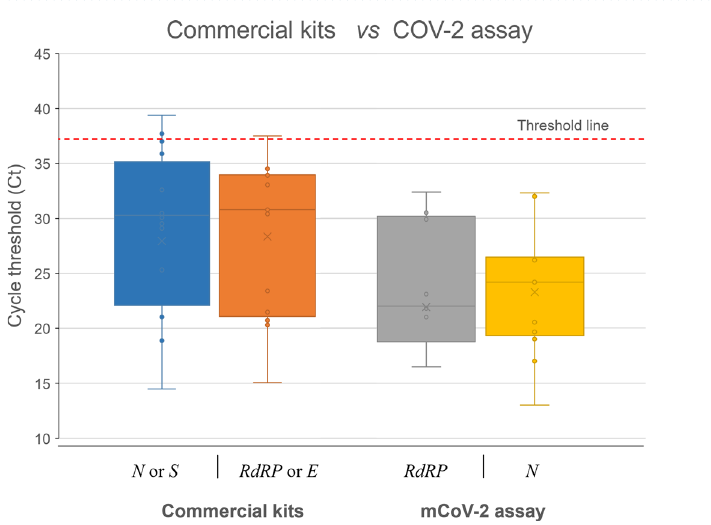
Figure 3. The cycle threshold (Ct) scores of the same clinical samples tested either the current mCoV-2 assay or commercial kits. Each bar represents different genes, which are RdRP (gray) and N (yellow) for mCoV-2 assay; and N or S (blue) and RdRP or E (orange) for commercial kits. Dashed line shows the positivity cut-off level equals to Ct